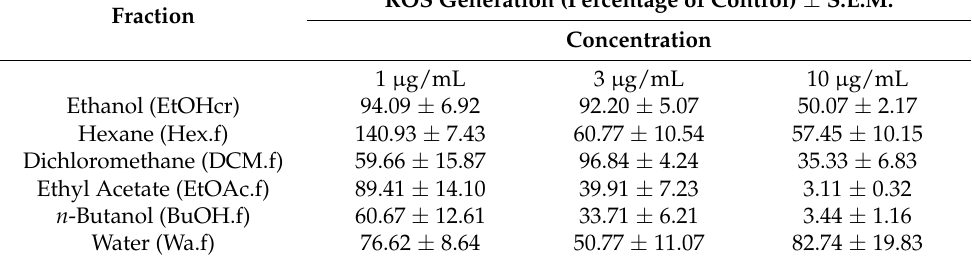
Table 1. Screening of ethanol crude extract and fractions from A. muricata L. leaves on ROS production by neutrophils stimulated with opsonized zymosan. Neutrophils were purified from the bone marrow of C57/BL6 mice through Percoll density gradient. EtOH.cr extract and fractions from A. muricata L. leaves were prepared following the liquid-liquid partition method. In a concentration-response curve, 2 × 10 5 neutrophils were pretreated for 30 min with different concentrations of each fraction, and then the cells were stimulated with Zy-Ops. ROS production was monitored through chemiluminescence emission of luminol for 60 min. The percentage of ROS production was calculated considering Zy-Ops stimulated cells without any pretreatment as 100%. Data represent mean ± S.E.M. ROS Generation (Percentage of Control) ± S.E.M. Fraction Concentration 1 µ g/mL 3 µ g/mL 10 µ g/mL Ethanol (EtOHcr) 94.09 ± 6.92 Hexane (Hex.f) 140.93 ± 7.43 Dichloromethane